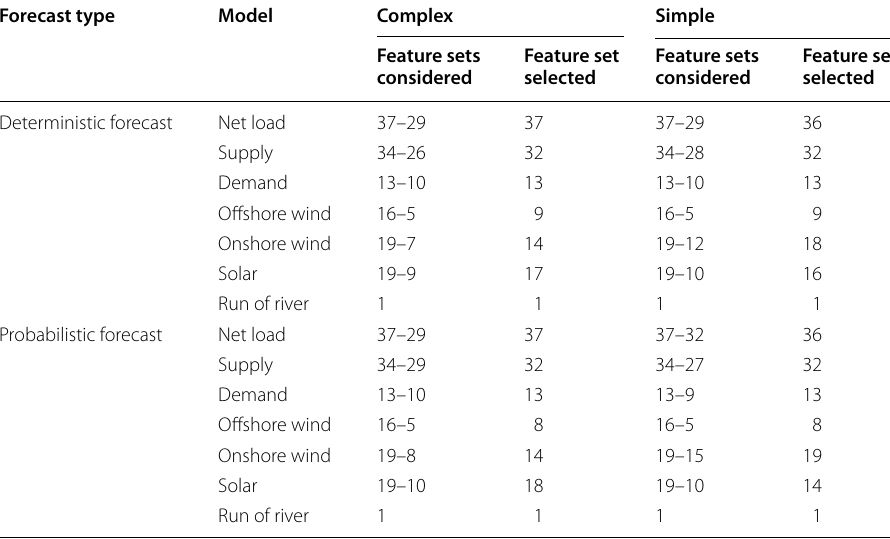
Table 2 Summary of feature sets considered for the optimisation and the resulting best performing feature set selected for each forecasting model